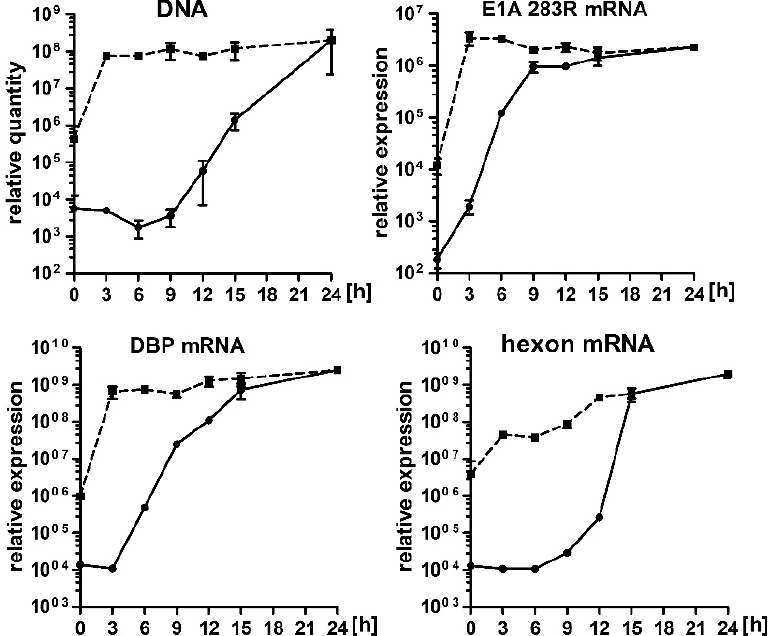
Figure 5. 17-AAG inhibits HAdV-5 transcription and DNA replication early after infection. A549 cells were infected with HAdV-5. At the indicated times 17-AAG was added to a final 0.25 μ M concentration (dotted line) or left without the inhibitor (solid line) and culture was prolonged to 24 h. 24 h after infection DNA and RNA was analyzed by q-PCR with primers specific for E1A, DBP, and hexon transcripts. DNA was analyzed using hexon-specific primers. The presented results are means and SD values from three experiments, normalized to results obtained for GAPDH.